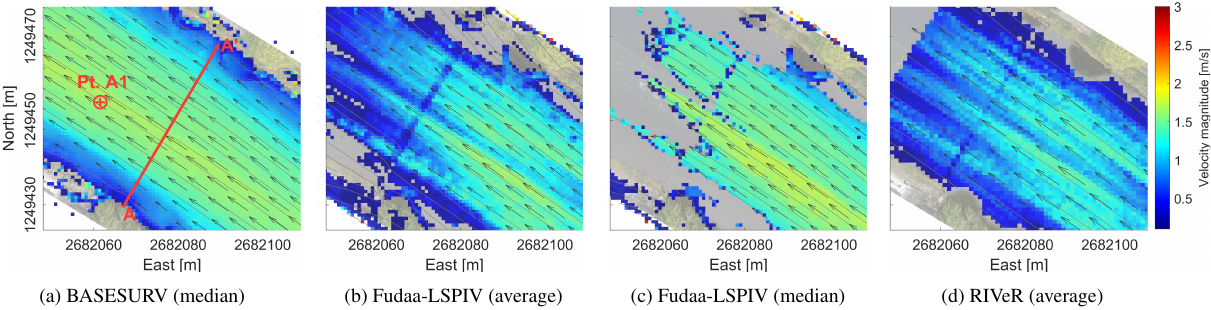
Figure 3. Time-averaged SVFs computed from dataset A: (a) BASESURV (median); (b) Fudaa-LSPIV (average); (c) Fudaa-LSPIV (median); (d) RIVeR (average). In (a) the location of the grid point Pt. A1 (Figure 4) and cross-section AA’ (Figure 5) are marked.